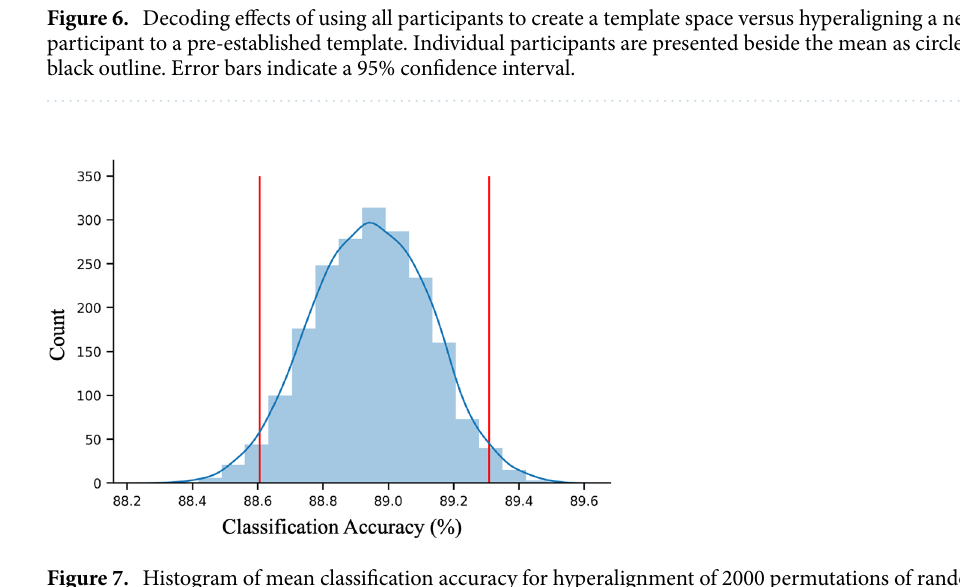
Figure 7. Histogram of mean classification accuracy for hyperalignment of 2000 permutations of random subject order. Red vertical bars demarcate the 95% confidence